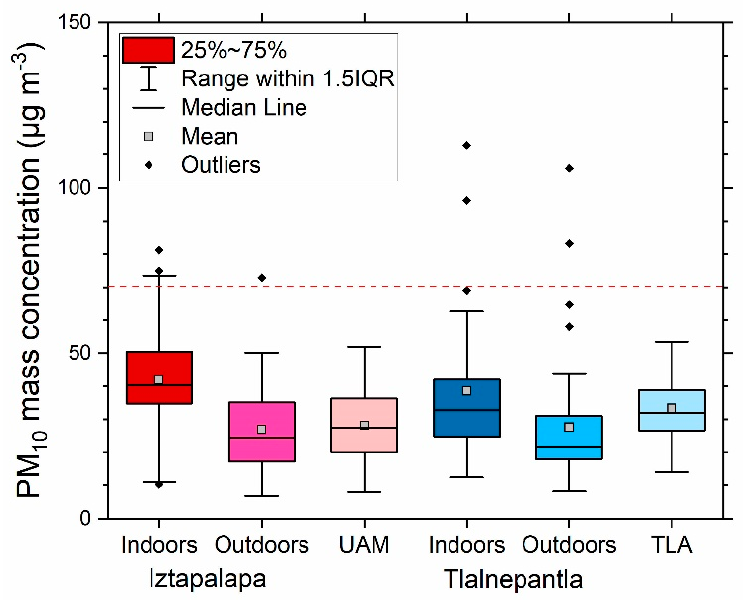
Figure 3. Tukey diagram for PM 10 gravimetric mass concentrations measured at both sampling sites and the nearest RAMA stations (UAM for Iztapalapa and TLA for Tlalnepantla). The dashed line represents the 70 µg m − 3 Mexican official standard.